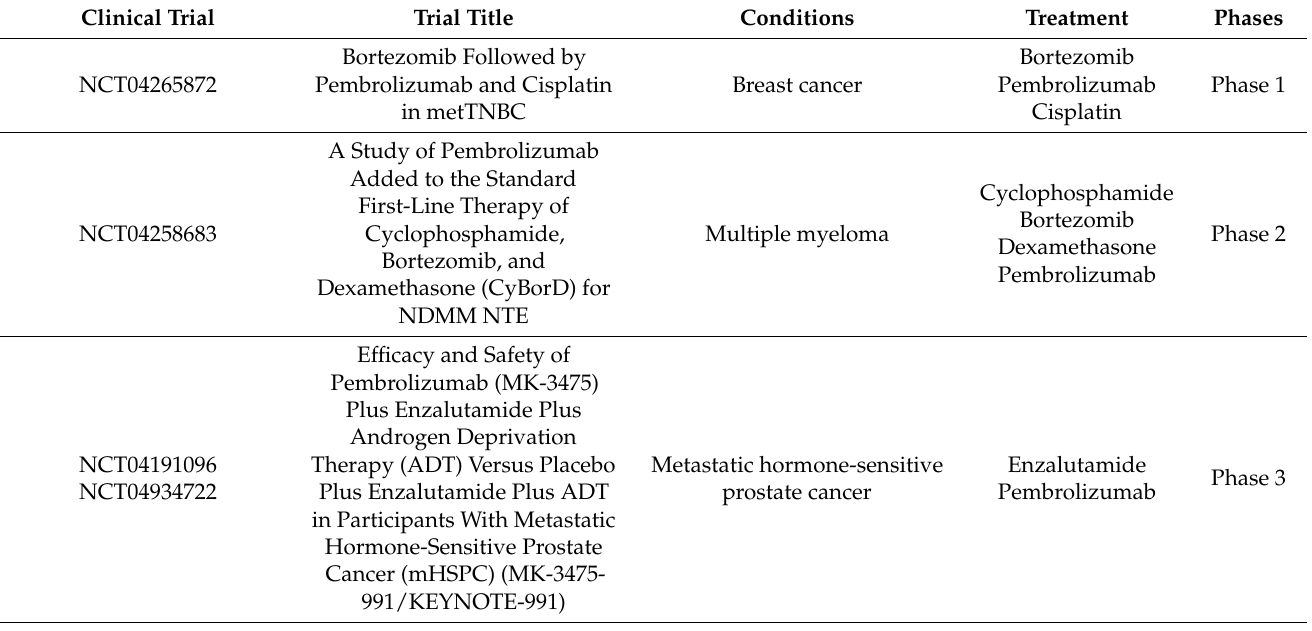
Table 3. Clinical trials investigating the combination of small molecule inhibitors with immune checkpoint